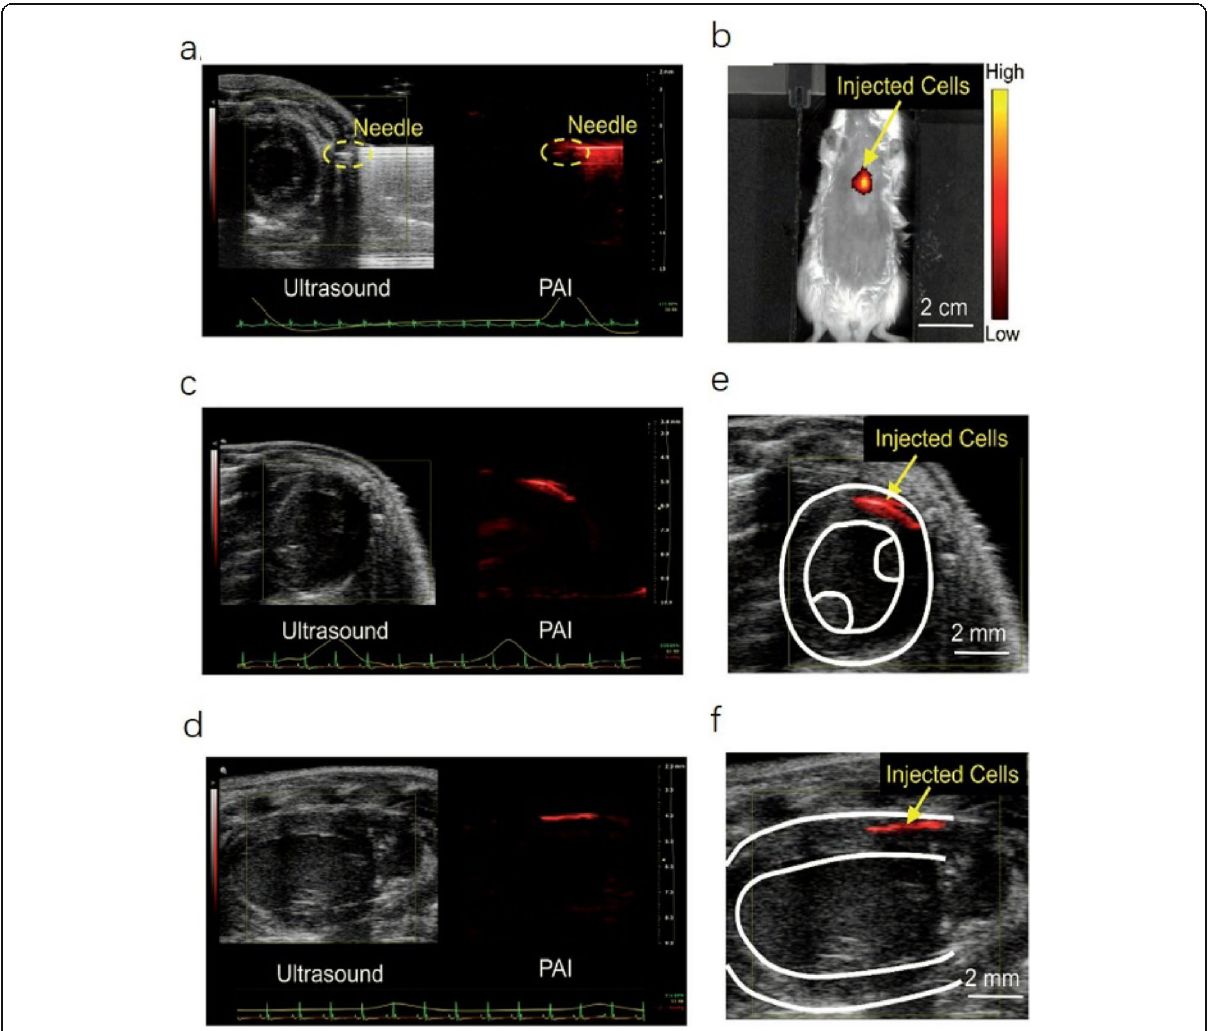
Fig. 3 PAI of the injection and engraftment of PANP-labeled hESC-CMs in mouse hearts in vivo